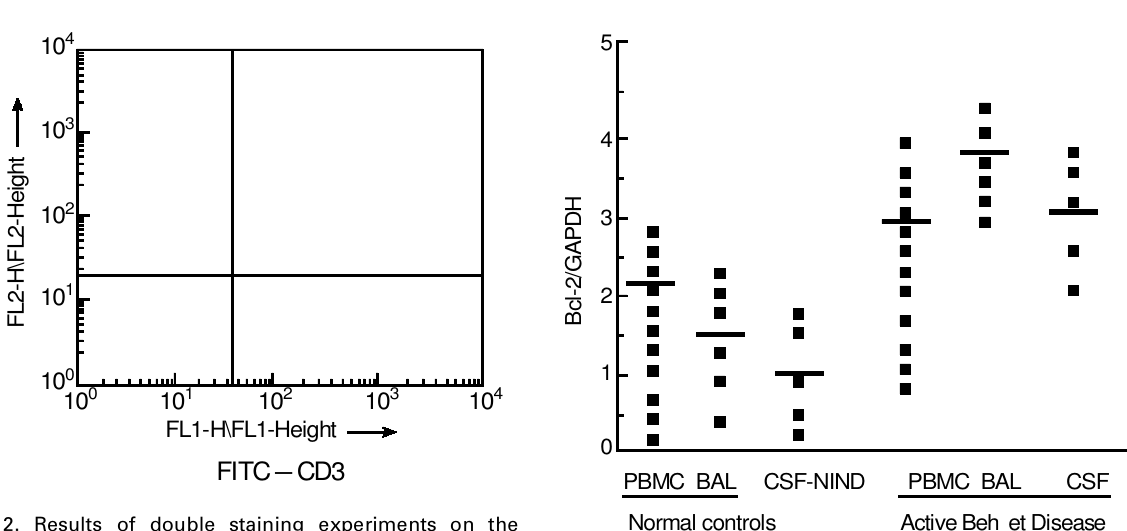
FIG. 3. The expression of Bcl-2 mRNA in peripheral blood, bronchoalveolar lavage (BAL) and cerebrospinal fluid (CSF), cells from patients with active Behçet’s disease (BD). Seven micrograms of total RNA were blotted onto nylon membrane and hybridized sequentially with Bcl-2 and GAPDH probes. The dots represent the ratios of densitometric reading of Bcl- 2 and GAPDH expression. Each dot represents one patient. Mean values are indicated by a